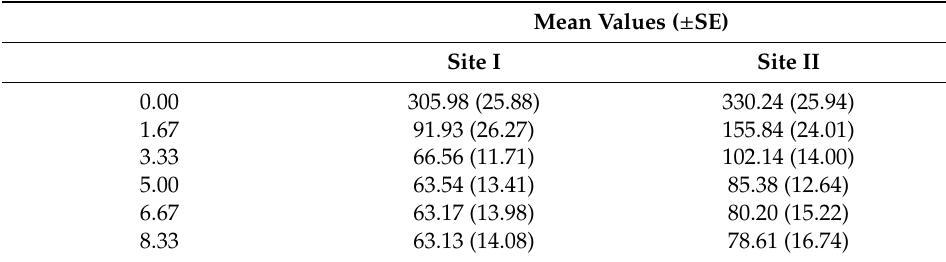
Table 7. Mean values and standard errors (SE) estimated from the exponential decay model (Equation (3)) of the weed dry biomass as a ff ected by the di ff erent foam doses (0, 1.67, 3.33, 5.00, 6.67 and 8.33 L m − 2 , respectively) and the site at 37 days after the treatment in the Festuca arundinacea (Schreb.) infested field experiment. The non-linear regression curves are plotted in Figure 7.